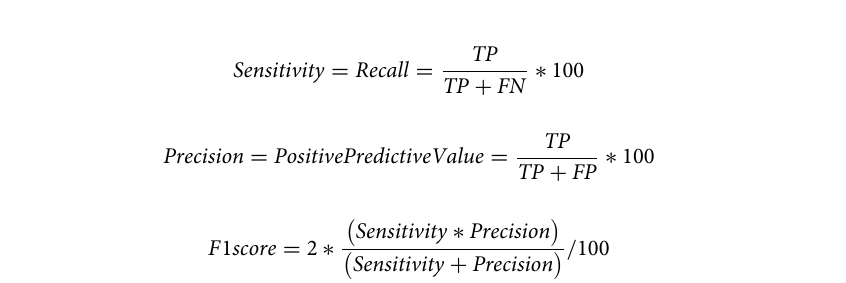
Figure 2. Image preprocessing workflow in a patient with an aneurysm of the right middle cerebral artery (arrow) and Fisher 4 bleeding (intraventricular hemorrhage indicated by *) with mid-line shift. Fully automated brain mask computation, overlaid in green, from acquired head and neck CTA source images ( a ). Extracted brain image ( b ). 3D rendered computed vessel enhanced images with scale 0.5–5 voxels ( c ) and 5–15 voxels ( d